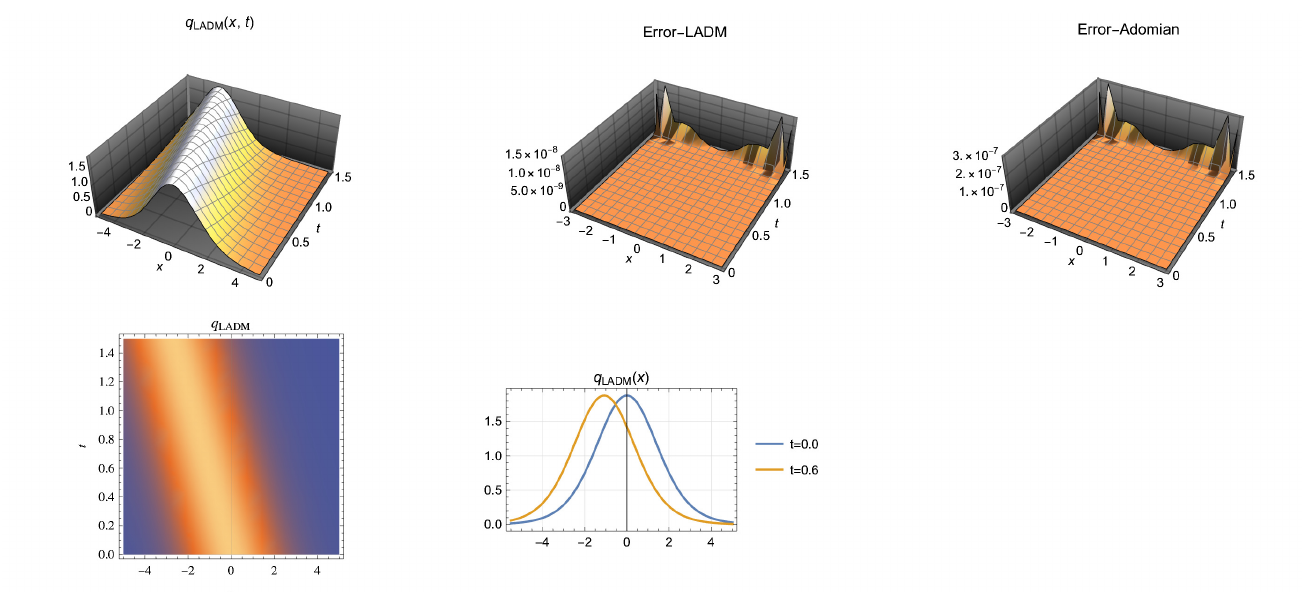
Figure 2. Soliton profile q LADM ( x , t ) in the interval − 4.0 ≤ x ≤ 4.0, for the parameters selected in Case 2 ( above left ). Error by LADM ( above center ) and error by Adomian method ( above right )). Density graph ( bottom left ). Two dimensional (2D) graph for t = 0.0 and t = 0.5 ( bottom right